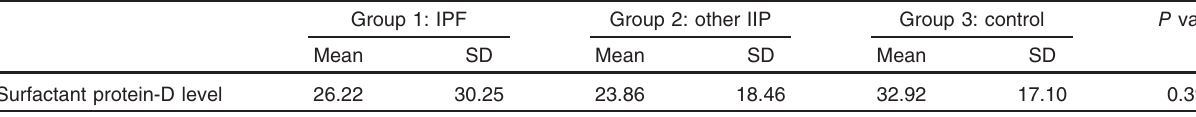
Table 4 Serum surfactant protein-D level in different groups of the study population Group 1: IPF